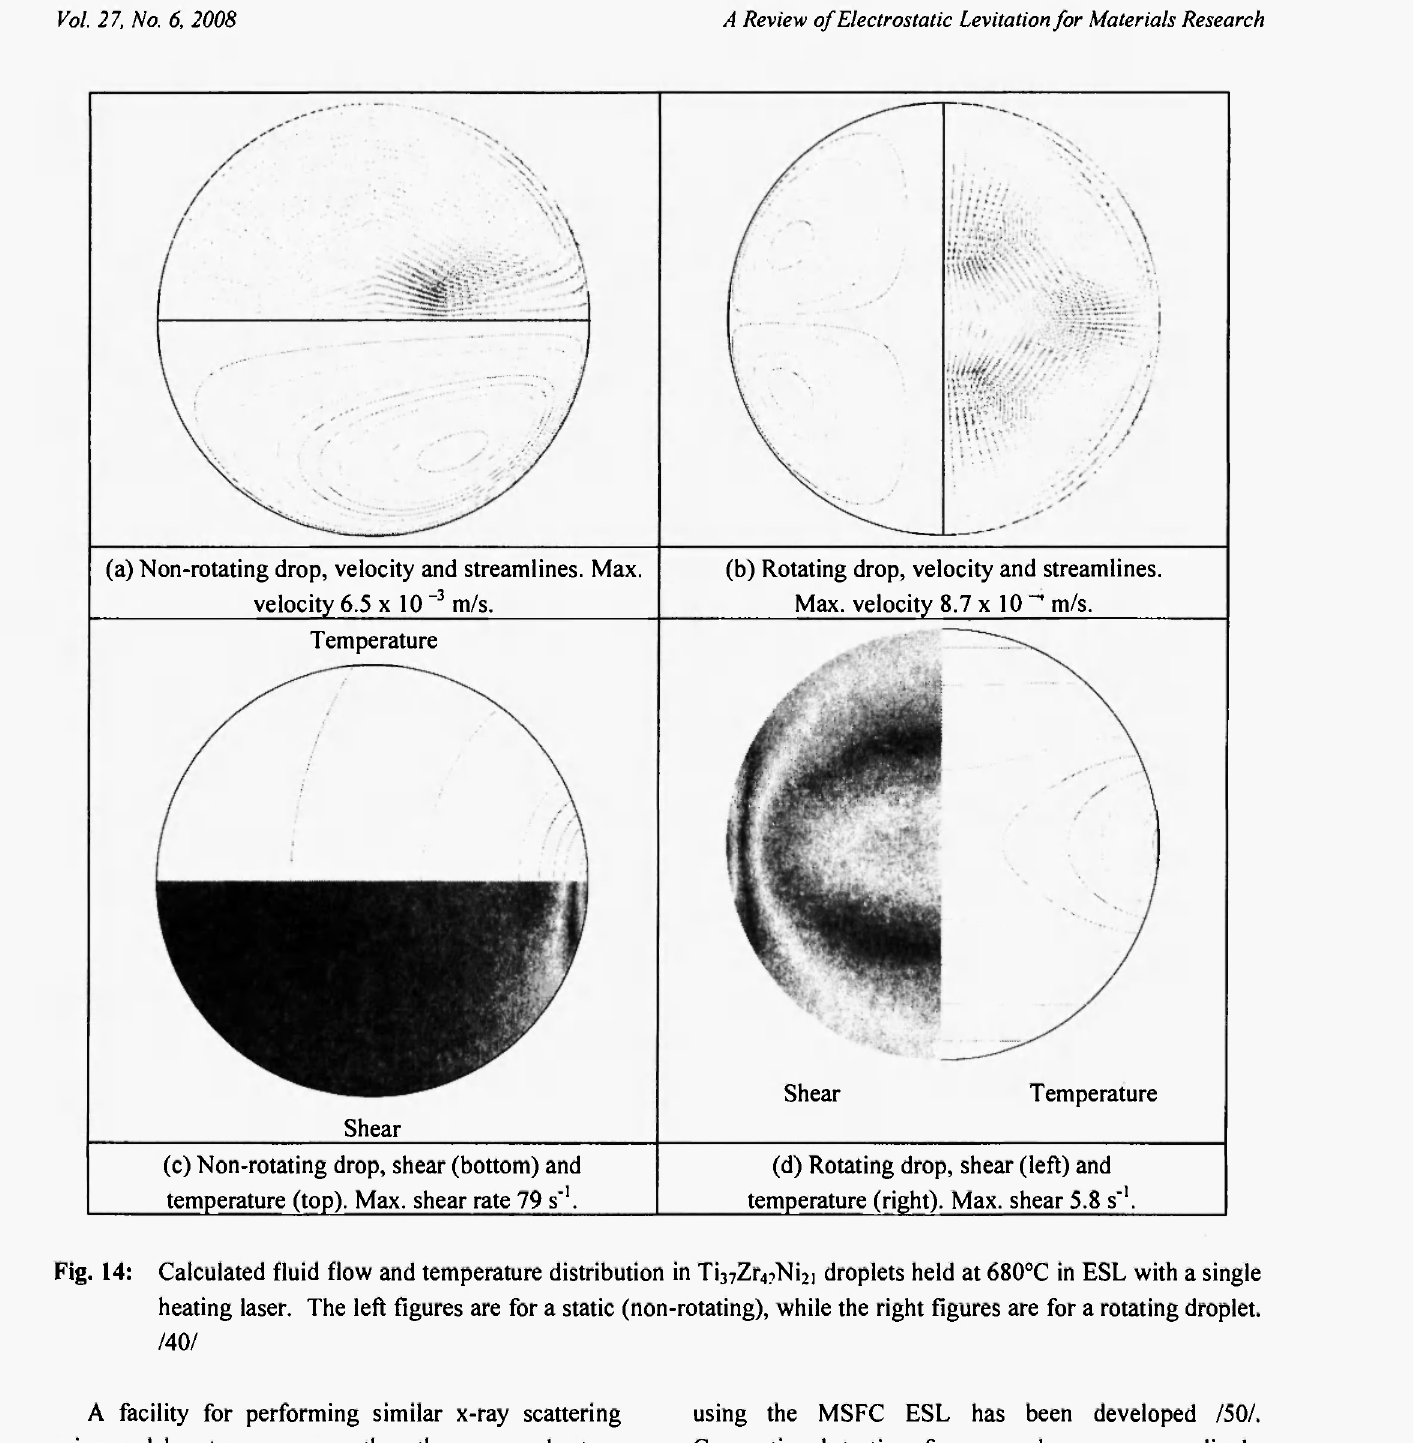
(b) Rotating drop, velocity and streamlines. Max. velocity 8.7 χ 10 m/s.